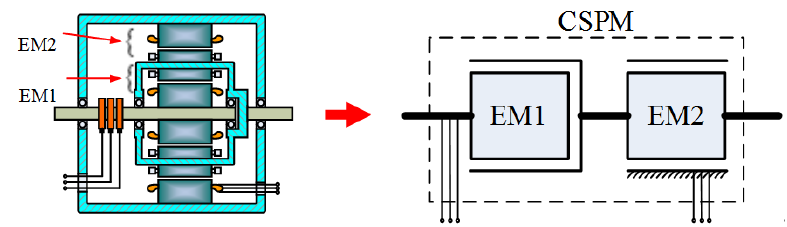
Figure 2. Equivalent diagram of compound-structure permanent-magnet motor.